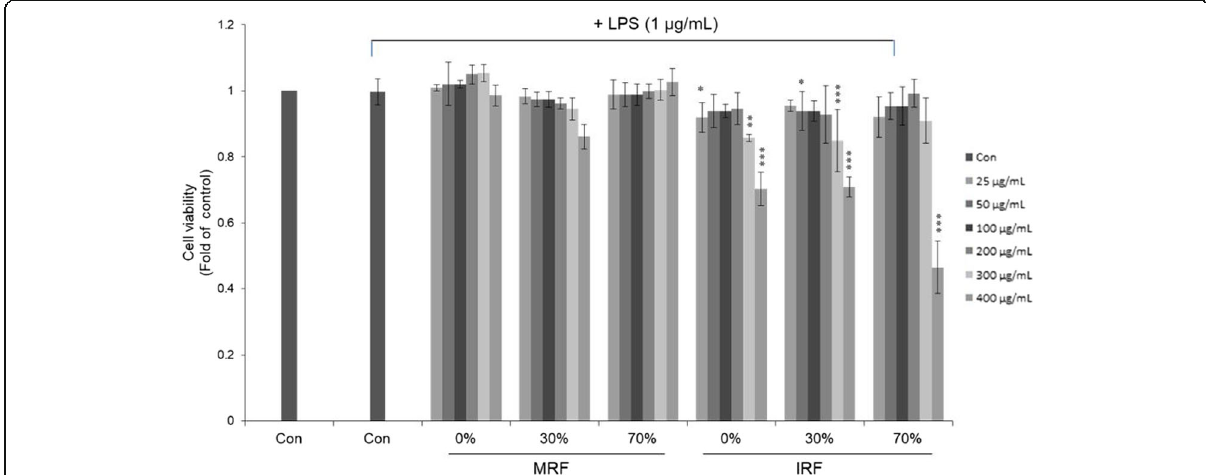
Fig. 1 Cell viability of Rubus coreanus fruit (RF) extracts on lipopolysaccharide (LPS)-induced RAW264.7 cells. Cells were pretreated various concentrations of mature RF (MRF) and immature RF (IRF; 25, 50, 100, 200, 300, and 400 μ g/mL) for 1h and then 1 μ g/mL LPS with extracts for 18h. Cell viability was